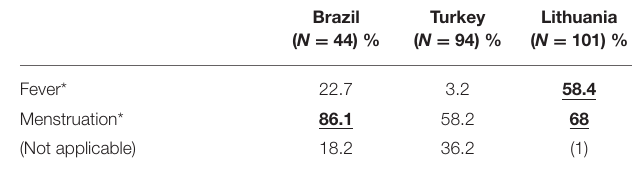
TABLE 8 | Discordant rates of attack modulatory factors in patients with migraine among the three different countries.